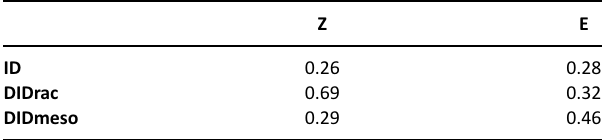
Table 1. Calculated RMSD values (in Å) of the ID , DIDrac , and DIDmeso FOCI-AM1 and RI-MP2 optimized structures.